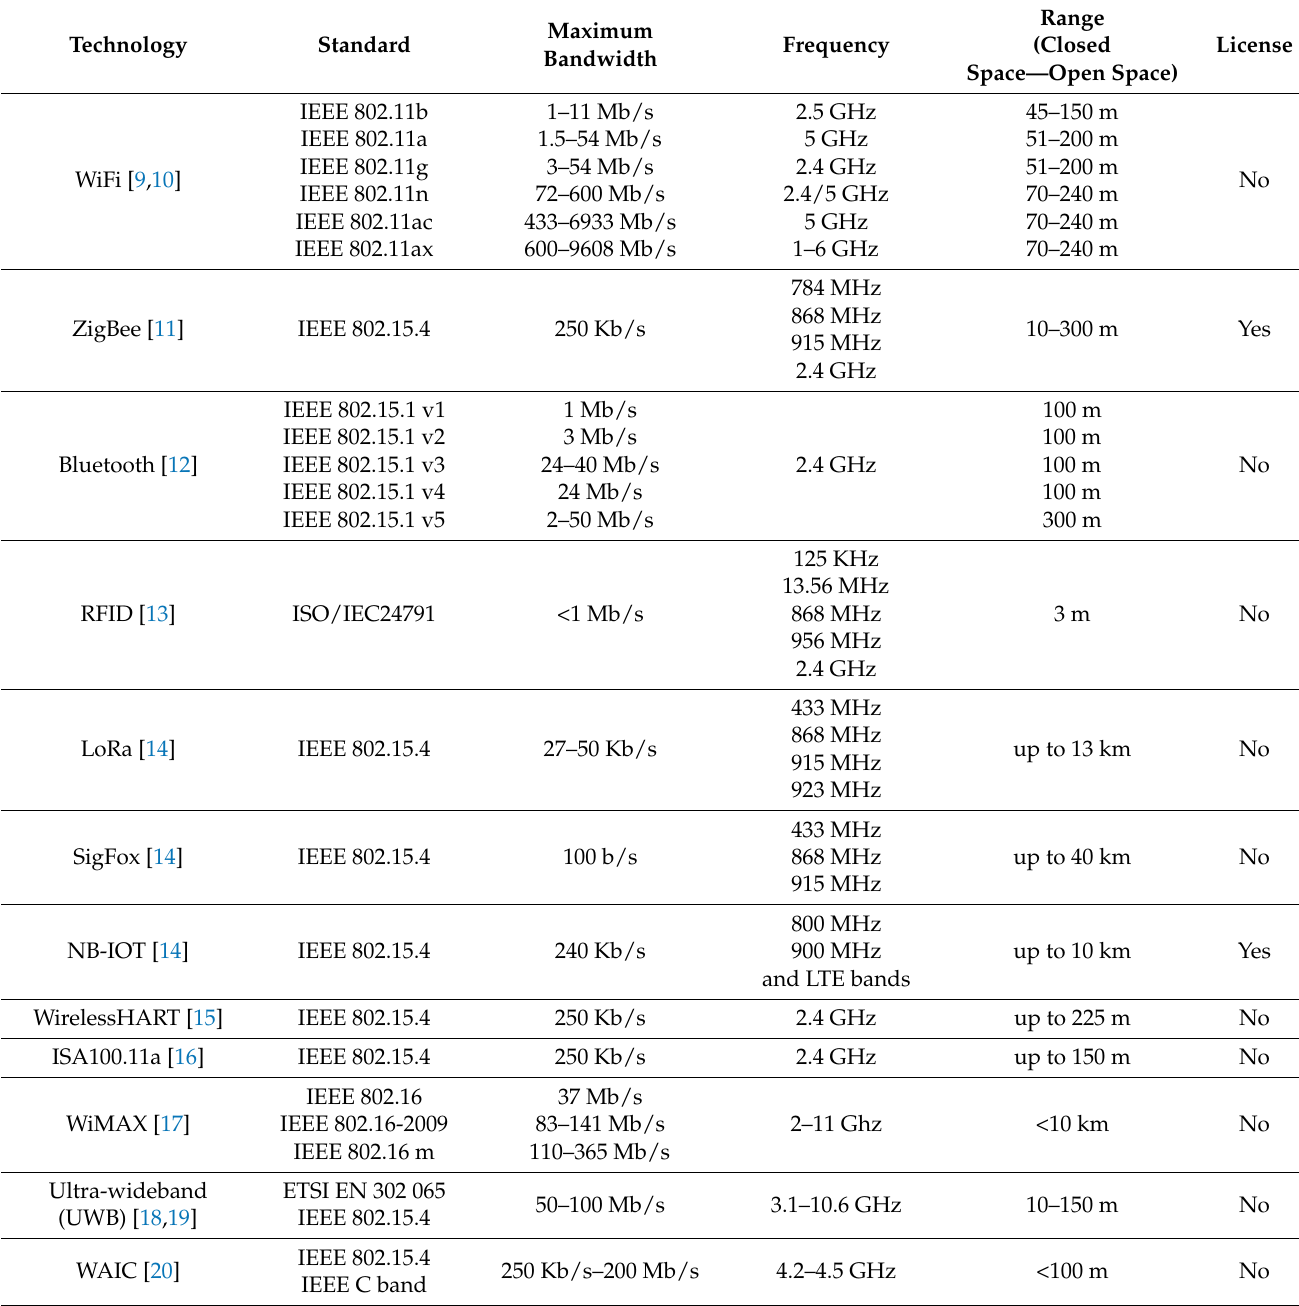
Table 1. Comparison of selected parameters of different wireless